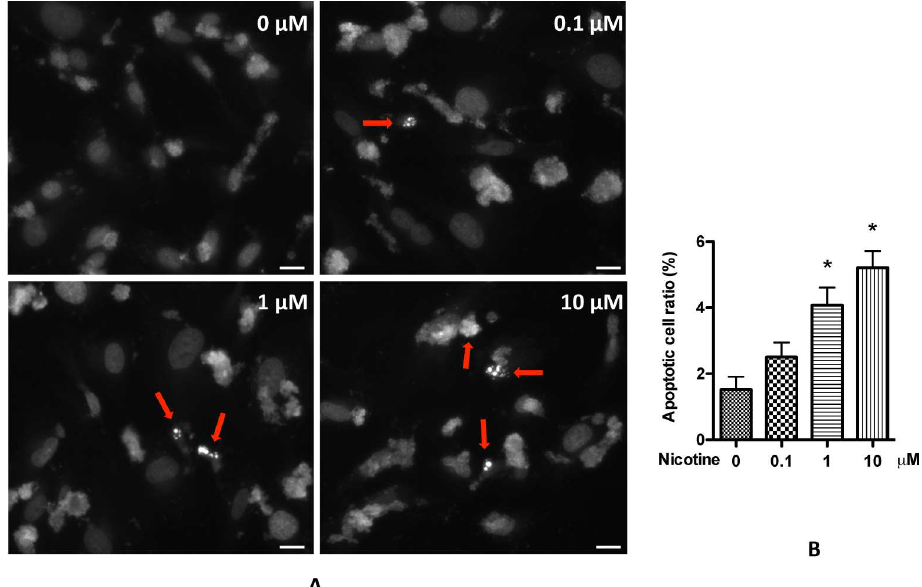
Fig 3. Nicotine induces podocyte apoptosis. Differentiated human podocyteswere treated with nicotine (0.1–10 μ M) for 48 h. Apoptoticcells were then determinedand counted by using Hoechst staining, as describein Materialsand Methods. A. Representative pictures were selectedto show the apoptotic cells (red arrow). Scar bar was for 50 μ m. B. Results (mean ± SD) were calculatedfrom 20 pictures of each treatment. * , p < 0.05 comparedwith control (0 μ